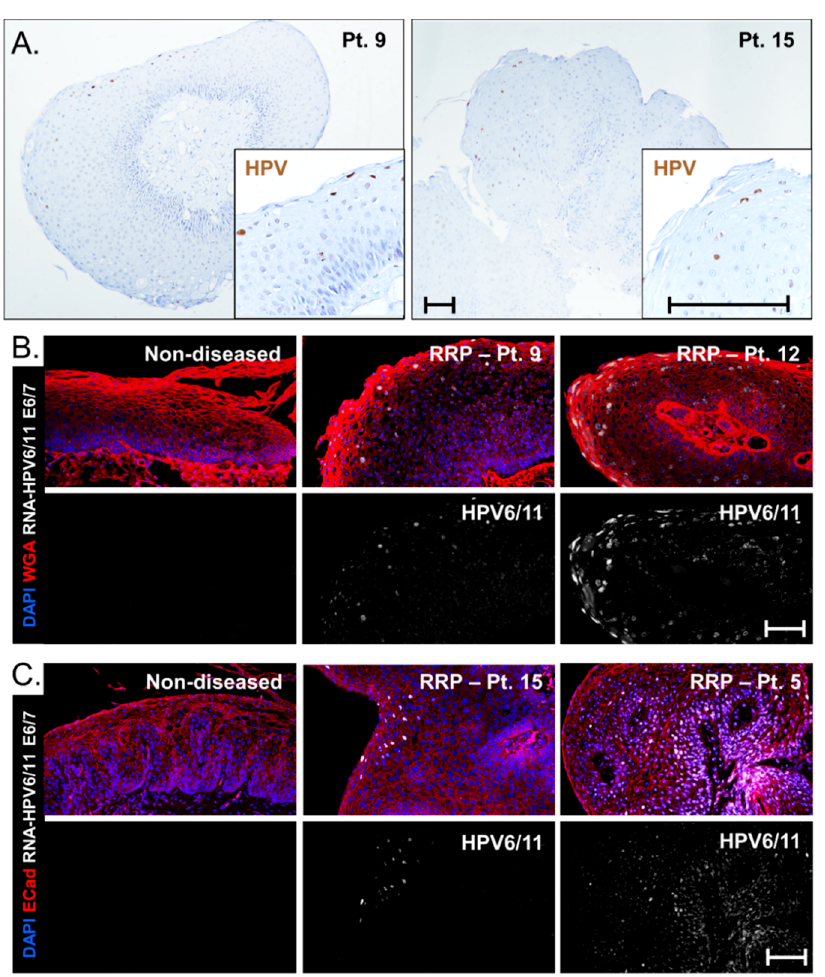
Figure 4. HPV viral gene expression levels vary across patients independent of HPV genotype. ( A ) Routine DNA-ISH on papillomas shows HPV+ positive cells predominantly in the more superfi- cial layers of the epithelium. Scale bar, 100 μ m. HPV6/11 viral E6 and E7 gene expression (white) by RNA ‐ ISH is variable in both ( B ) HPV6+ and ( C ) HPV11+ patient samples; scale bar, 100 μ m. Two patient samples are shown for both HPV6+ and HPV11+ samples. Nuclei are highlighted by DAPI stain (blue) with cell membranes stained in red by WGA ( B ) or ECad ( C ).